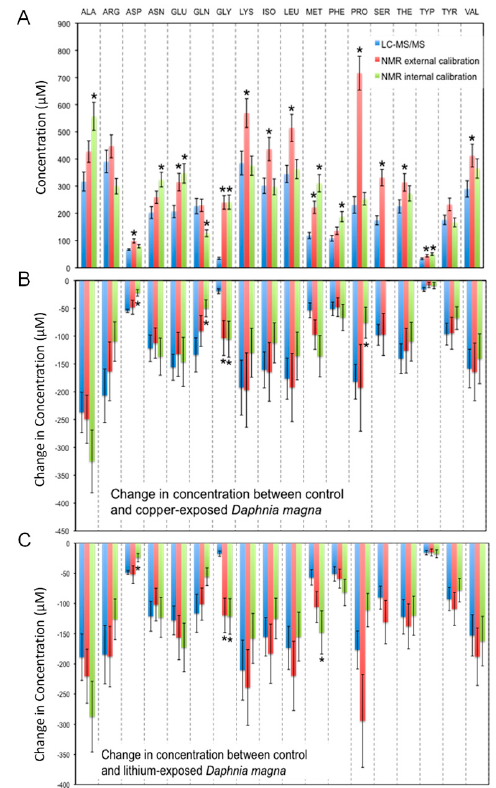
Figure 2. Concentrations of 18 amino acids observed in extracts of Daphnia magna by 1 H NMR and LC ‐ MS/MS (histidine was not quantified) expressed as ( A ) absolute concentrations observed in the extracts of control D. magna , or differences in amino acid concentrations observed between control D. magna and those exposed to ( B ) copper or ( C ) lithium. Any significant differences ( α = 0.05) between measured concentrations are denoted with an asterisk (*). ALA = alanine, ARG = arginine, ASP = as- partate, ASN = asparagine, GLU = glutamate, GLN = glutamine, GLY = glycine, ILE = isoleucine, LEU = leucine, LYS = lysine, MET = methionine, PHE = phenylalanine, PRO = proline, SER = serine, THR = threonine, TRP = tryptophan, TYR = tyrosine, VAL = valine. This excellent agreement is likely due to the concentration of these amino acids in